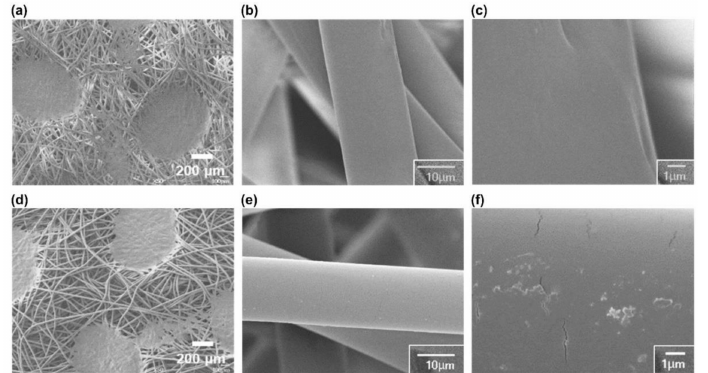
Figure 2. Field-emission scanning electron microscopy images of the spunbond polypropylene membrane of the KF94 mask ( a – c ) before and ( d – f ) after oxygen ion beam pretreatment and copper sputtering